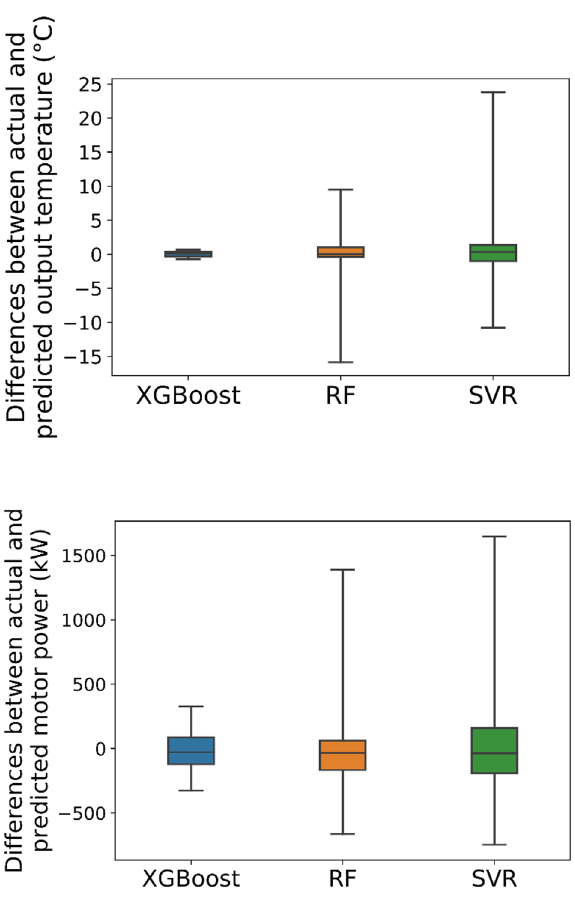
Figure 8. Differences between actual and predicted energy consumption indicative variables generated by various models in the testing